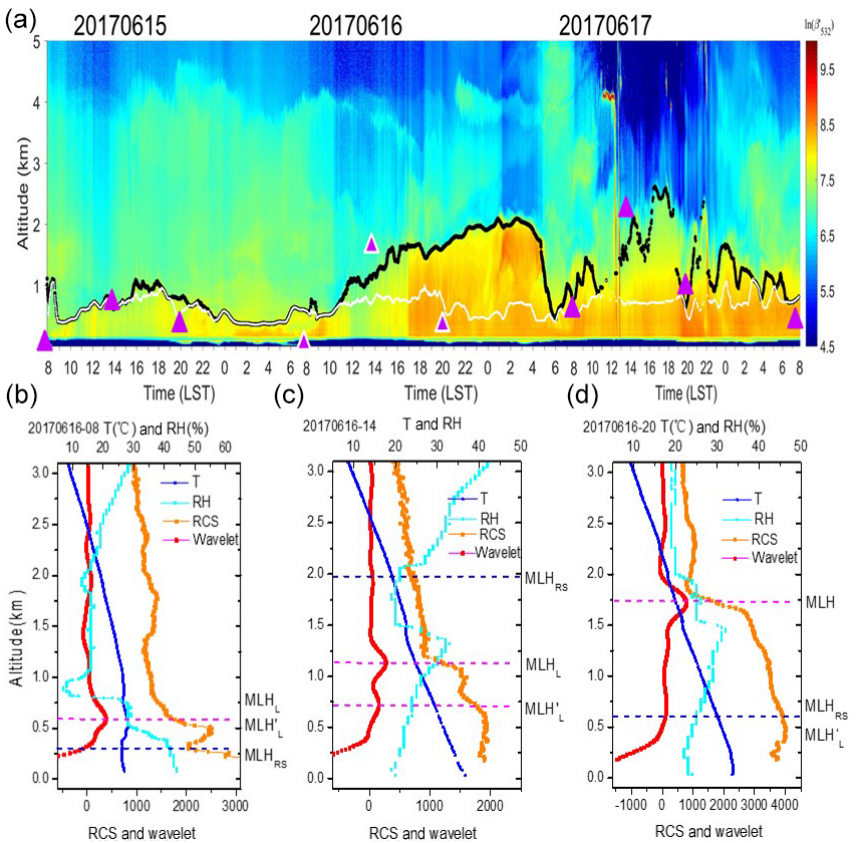
Figure 3. Similar to Fig. 1, but for (a) 15–17 June 2017, and with vertical profiles for (b) 08:00LST on 16 June 2017, (c) 14:00LST on 16 June 2017 and (d) 20:00LST on 16 June